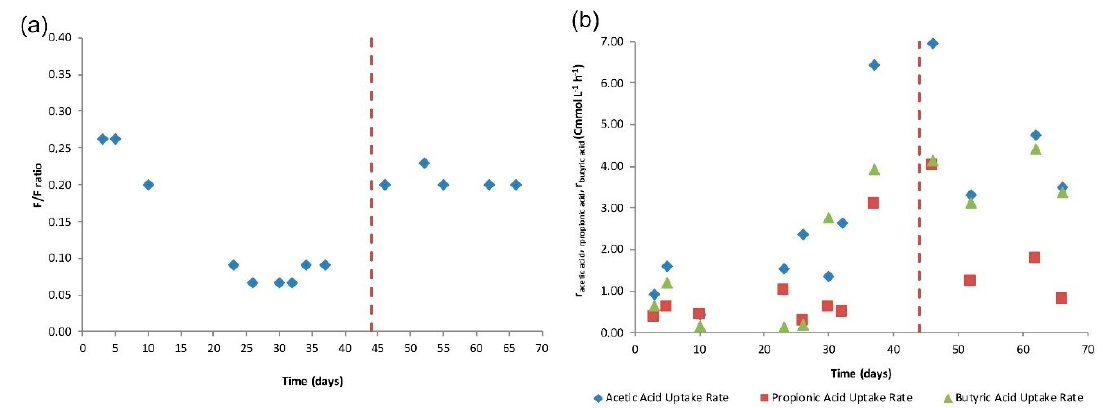
Figure 1. Evolution of F / F ratios ( a ) and uptake rates of acetic (blue diamonds), propionic (red squares) and butyric acids (green triangles) ( b ), along the SBR operational period. The red dashed line marked when cycle length and OLR were changed.